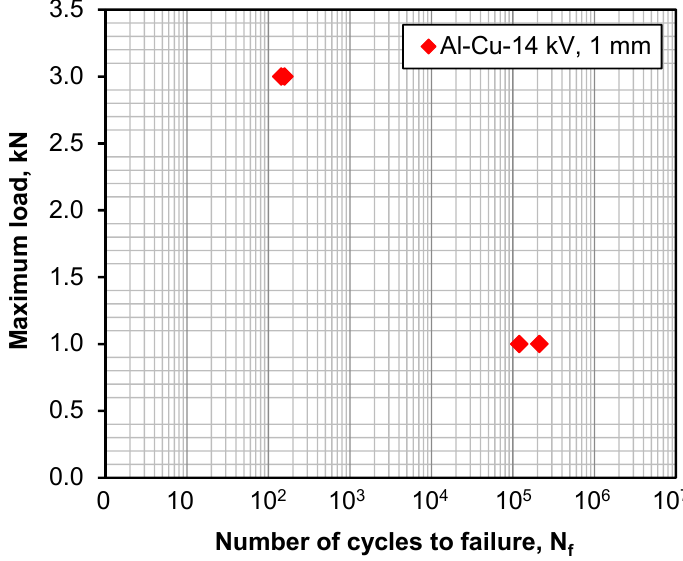
Figure 2. S-N curve of EMPWed Al / Cu dissimilar lap joints fatigued at two loading levels at RT, R = 0.2 and a frequency of 50 Hz.